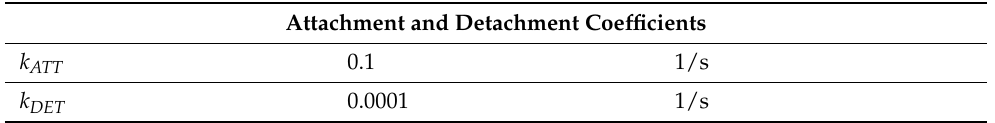
Table 4. Attachment and detachment coefficients for numerical model.